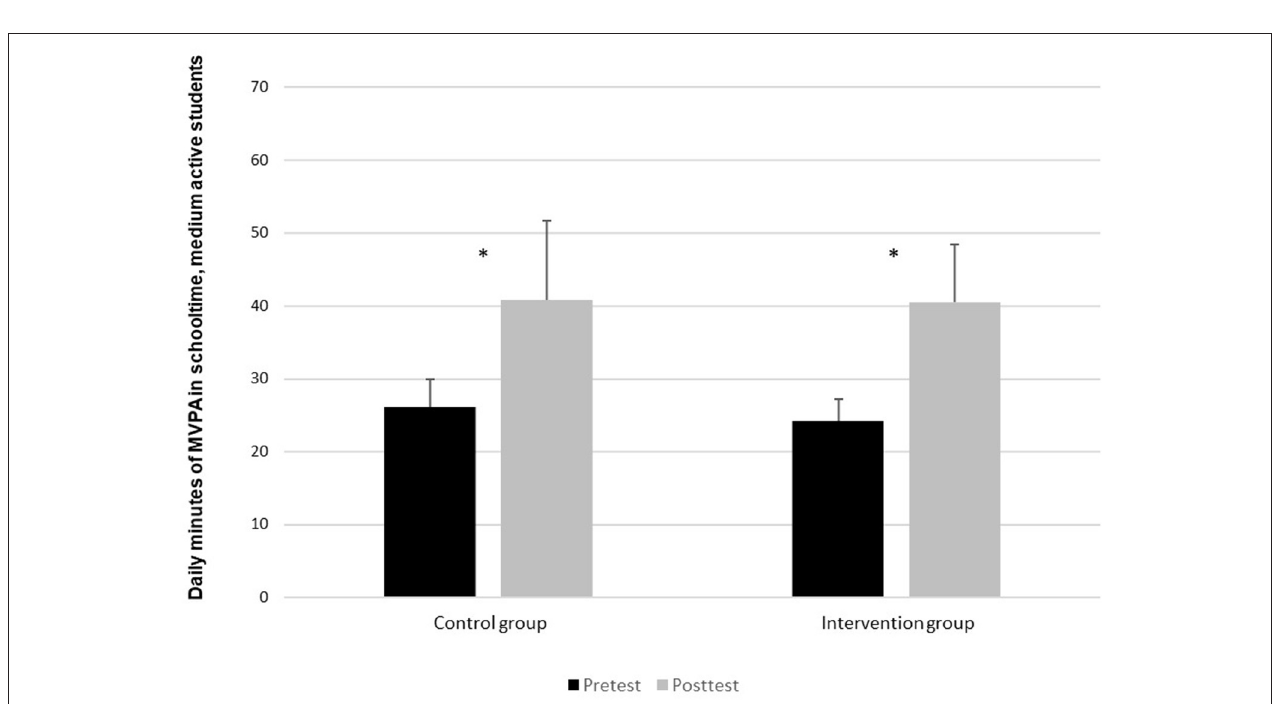
FIGURE 2 | Daily contribution of MVPA in schooltime for pupils in the low-activity group, divided between pre-test and post-test. *Indicates a significant difference ( p < 0.05) between pre-test and post-test in the daily MVPA during schooltime. l Indicates a significant difference ( p < 0.05) in MVPA development between the control group and the intervention group.